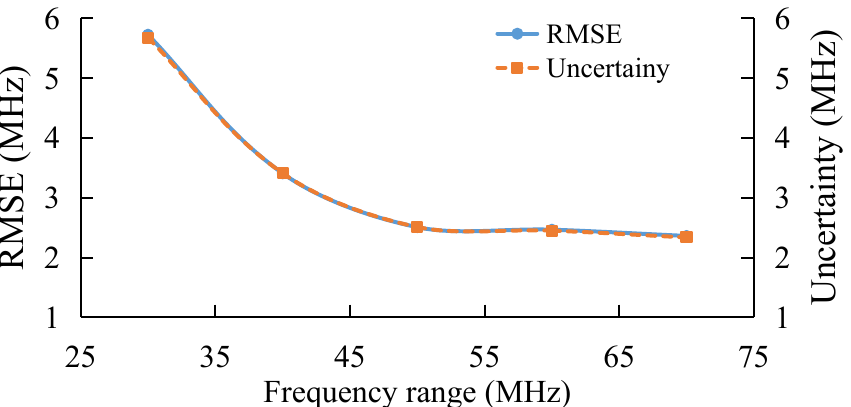
Figure 11. Experimental results under different frequency range.